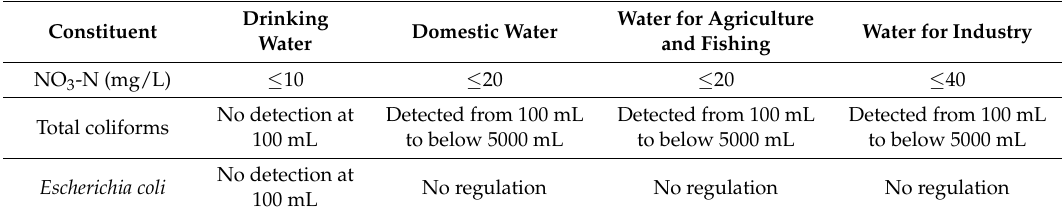
Table 1. Korea’s NO 3 -N groundwater standard.